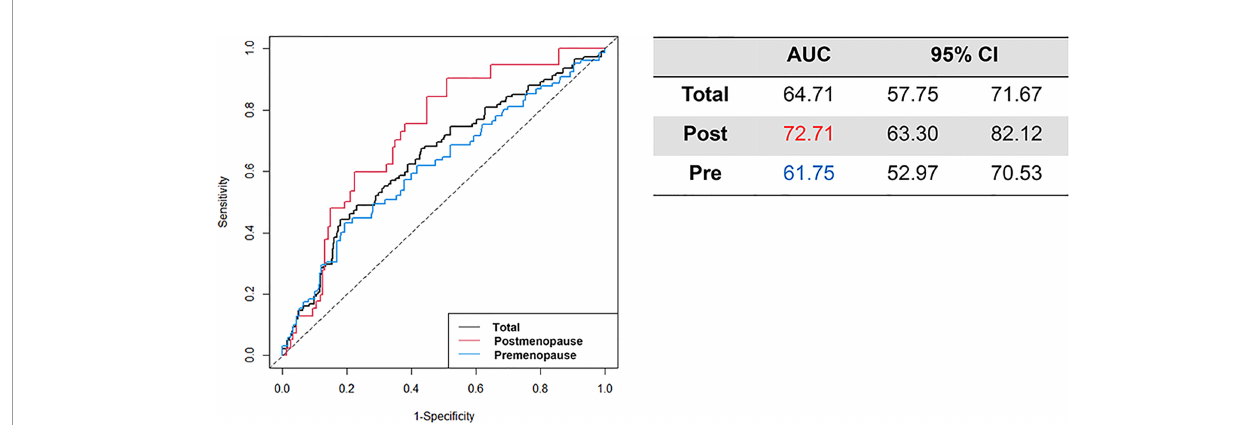
FIGURE 3 | Time-dependent AUC at 10 years post-surgery with 95% CI.